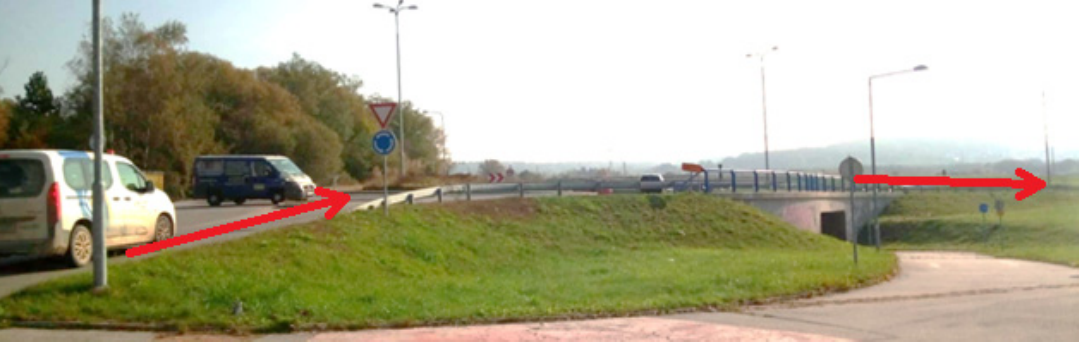
Figure 5. Elevated roundabout scenario on road II/156 in Č eské Bud ě jovice. Source: author.